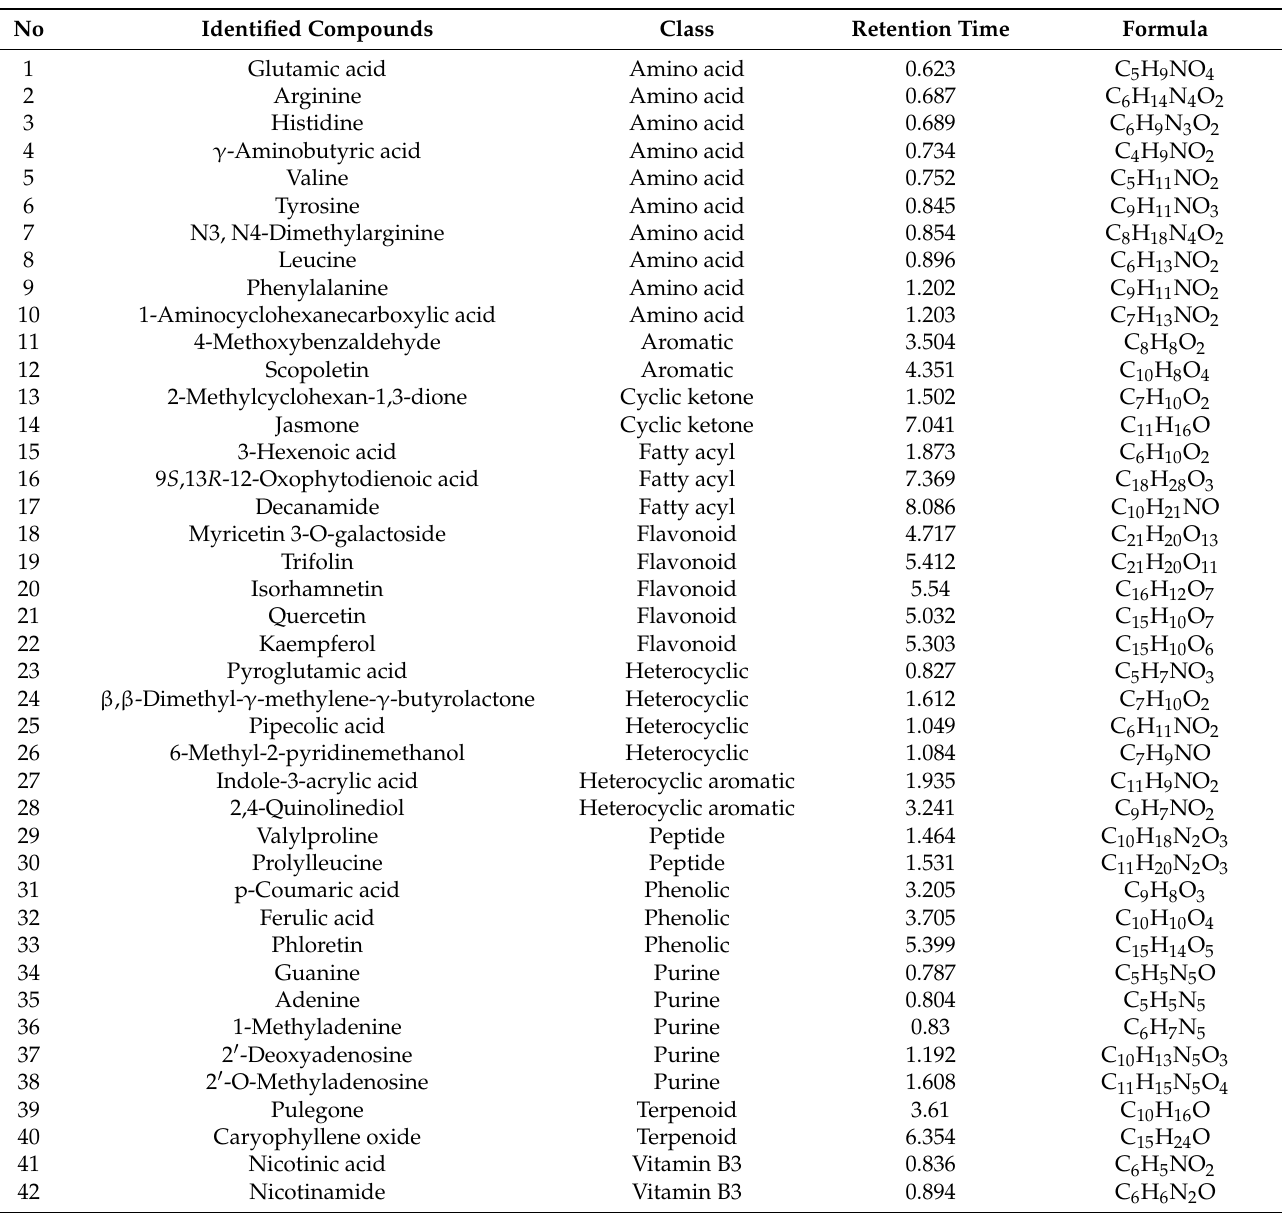
Table 3. Compounds identified from the aqueous extract of A. indica using Q Exactive HF Orbitrap mass spectrometry and Compound Discoverer 3.0. Number shows the respective compound structures can be referred in supplementary Figure